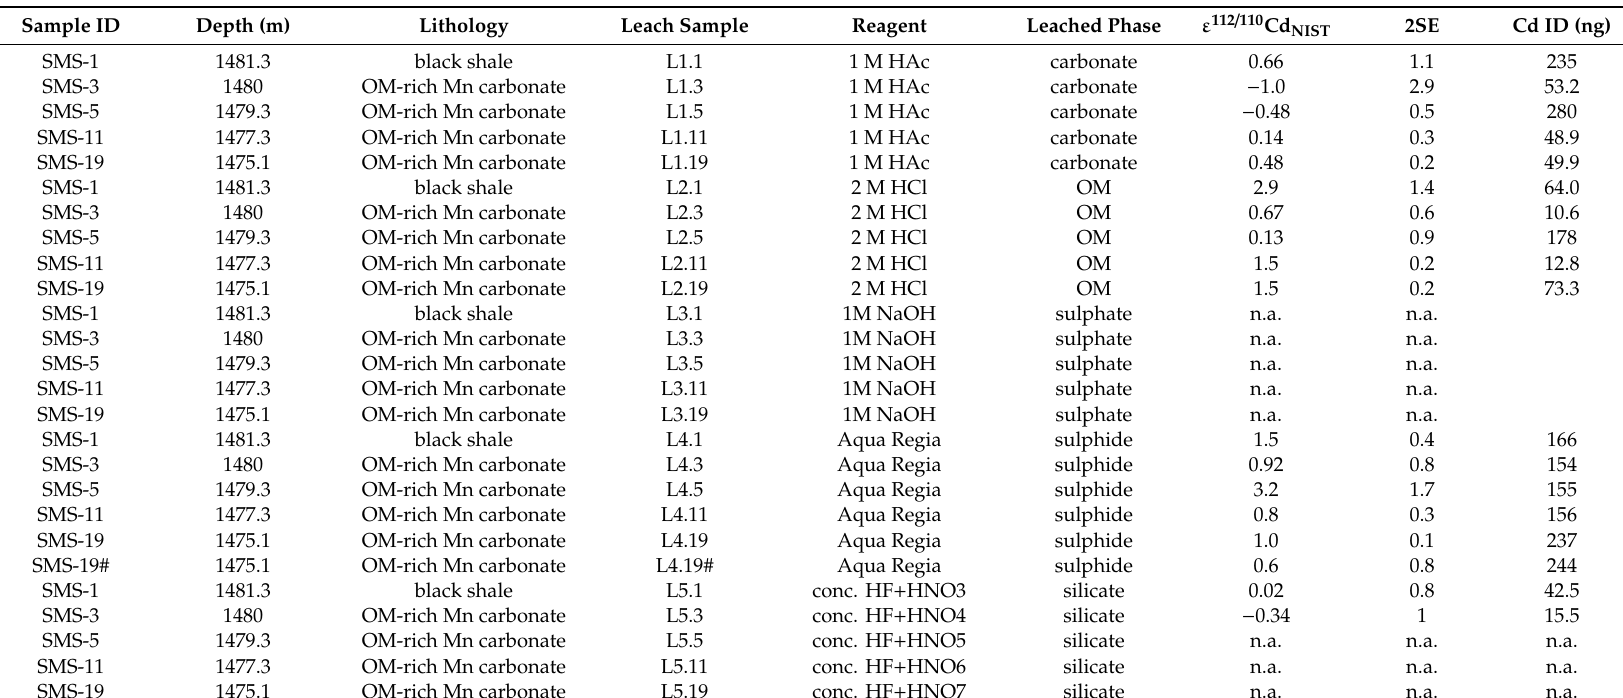
Table 3. Cd isotope compositions and Cd concentrations derived from isotope dilution